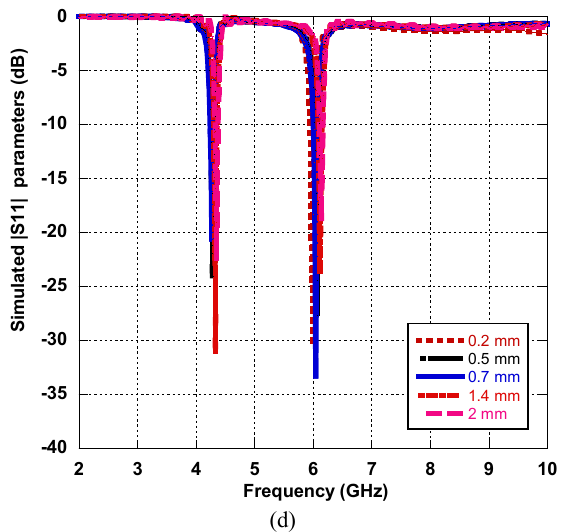
Figure 1: Geometry of the proposed dual band filter- antenna: (a) Top view. (b) Bottom view. (c) Simulated |S11|. (d) Parametric study of the distance gt .